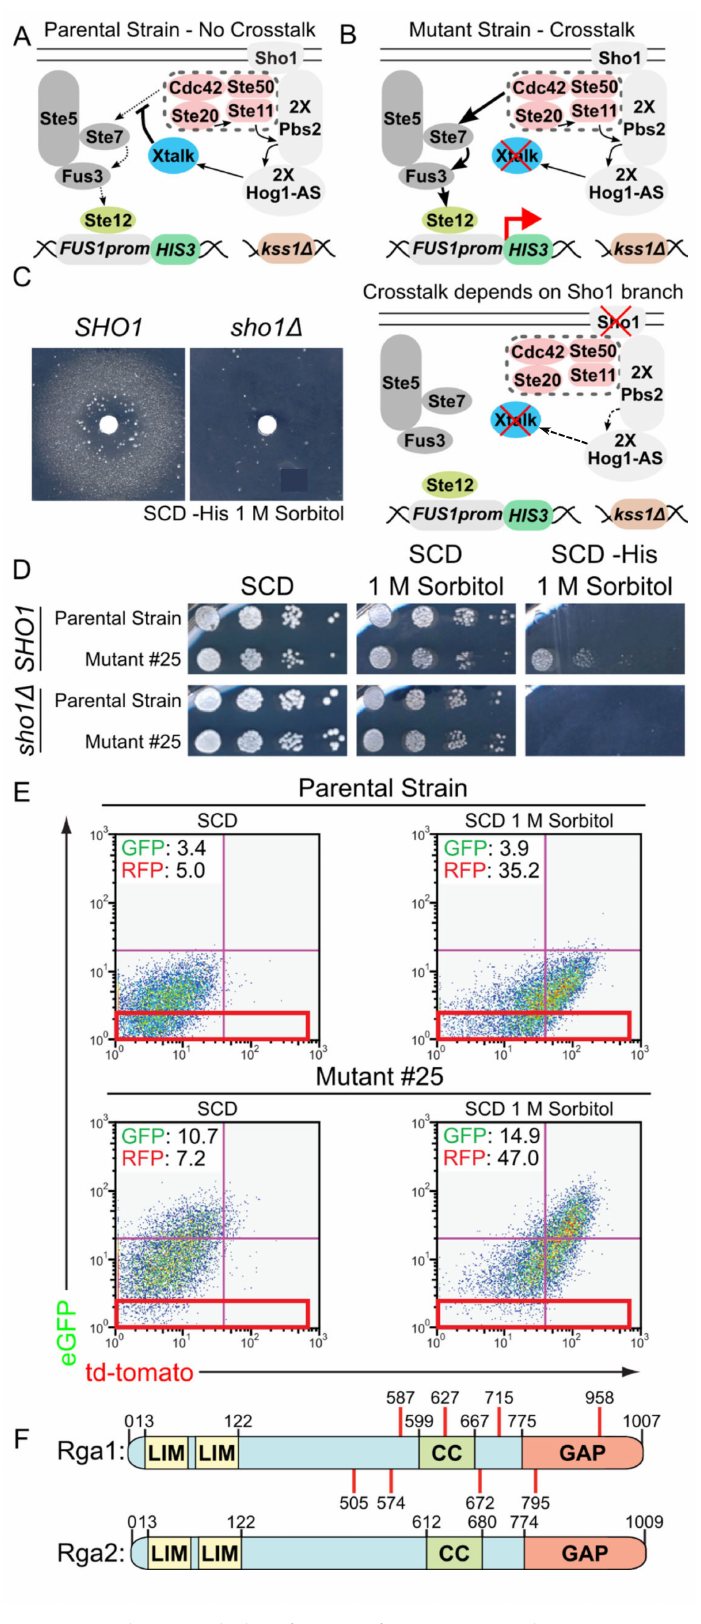
Figure 1. Isolation and identification of a gene required to prevent crosstalk. ( A ) Features of the strain constructed for genetic selection to identify genes required to prevent crosstalk. The Sho1 branch